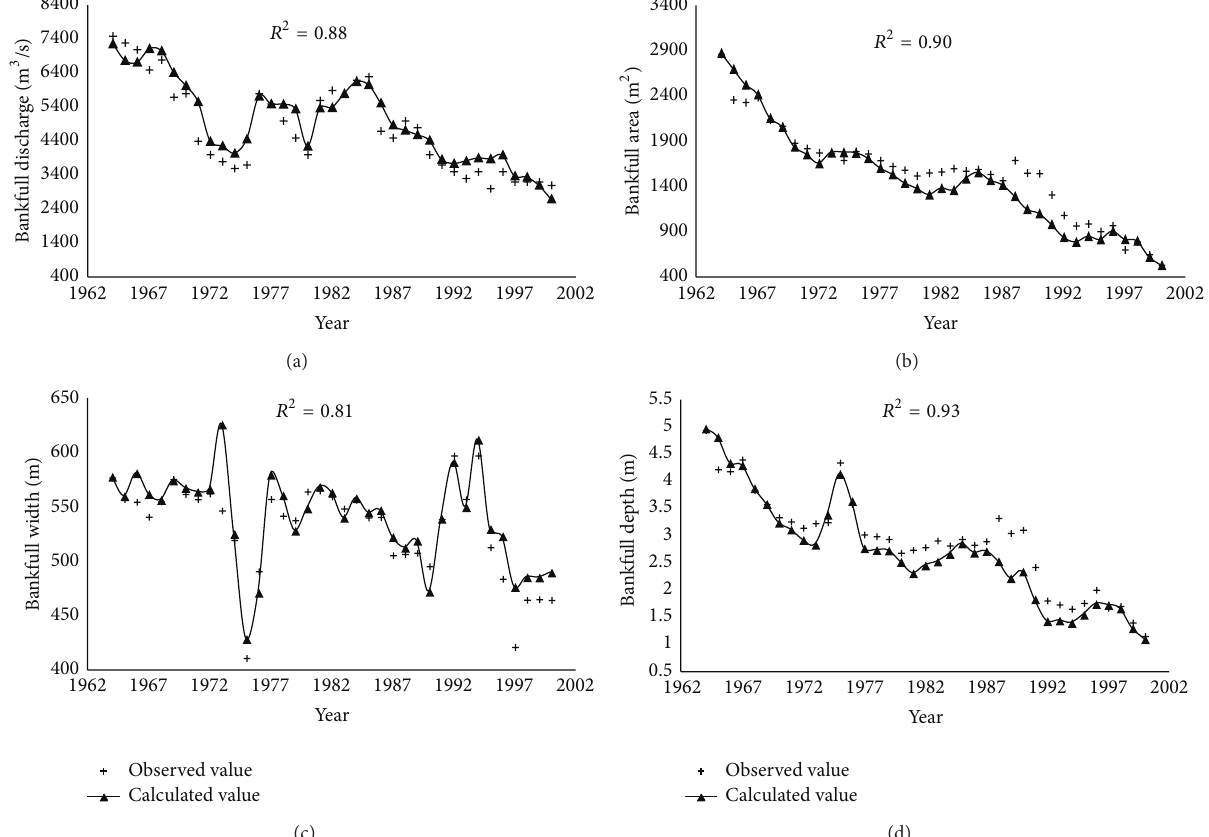
Figure 10: Bankfull computational results at Lijin Station for 38 years: bankfull (a) discharge; (b) area; (c) width; and (d) depth.